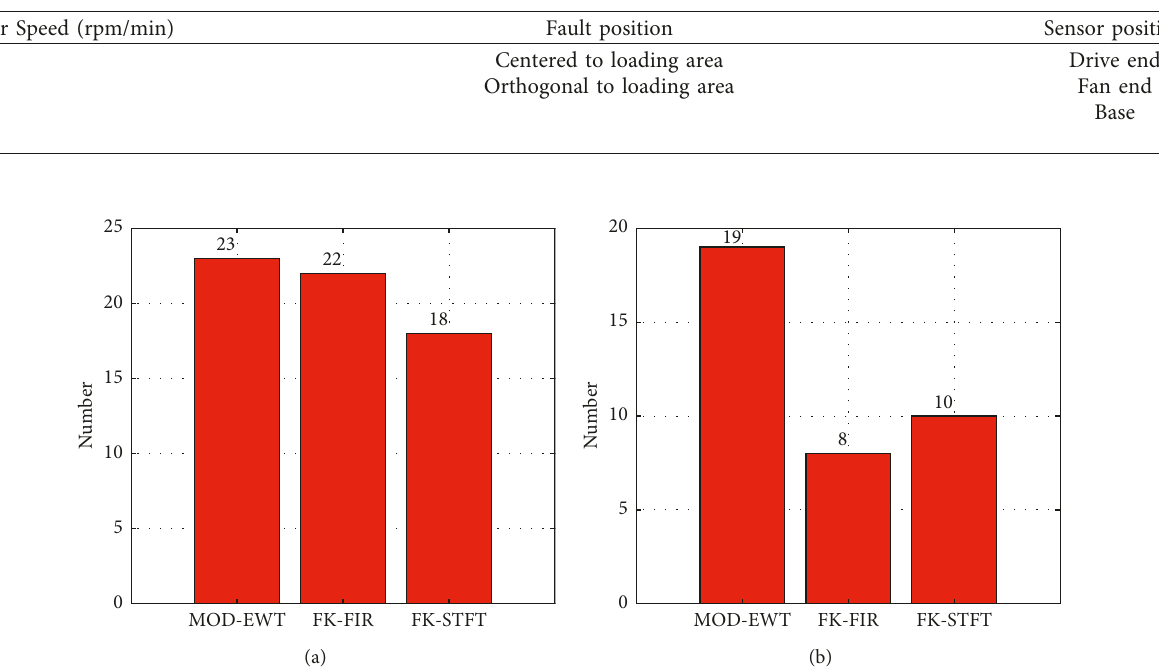
Figure 23: Number of groups with (a) diagnostic capability by using the results of three methods and (b) better diagnostic capability by using the results of three methods.